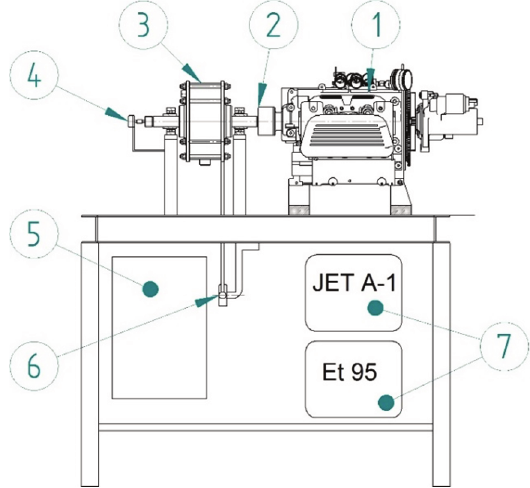
Fig. 4. SBB test stand scheme: 1 – prototype 1-cylinder engine, 2 – clutch, 3 – water brake HW 200, 4 – encoder, 5 – measuring box, 6 – strain gauge,